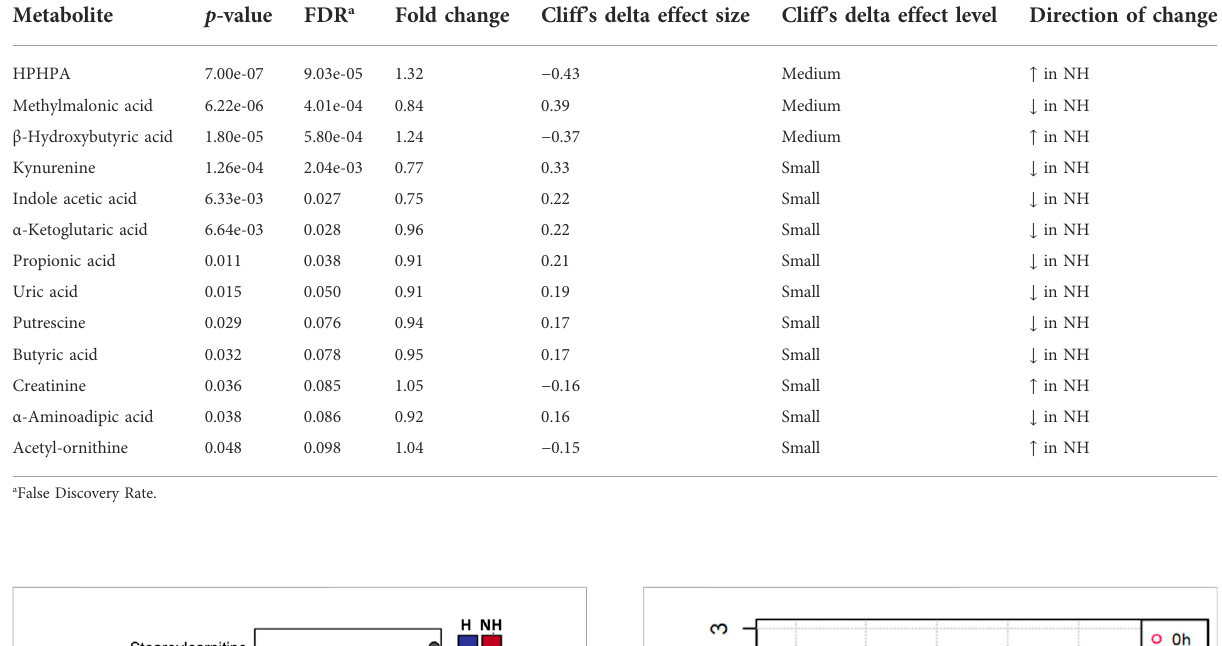
TABLE 3 Metabolites signi fi cantly ( p < 0.05) affected by treatment (H = Habituated; NH = Non-habituated) in goats.